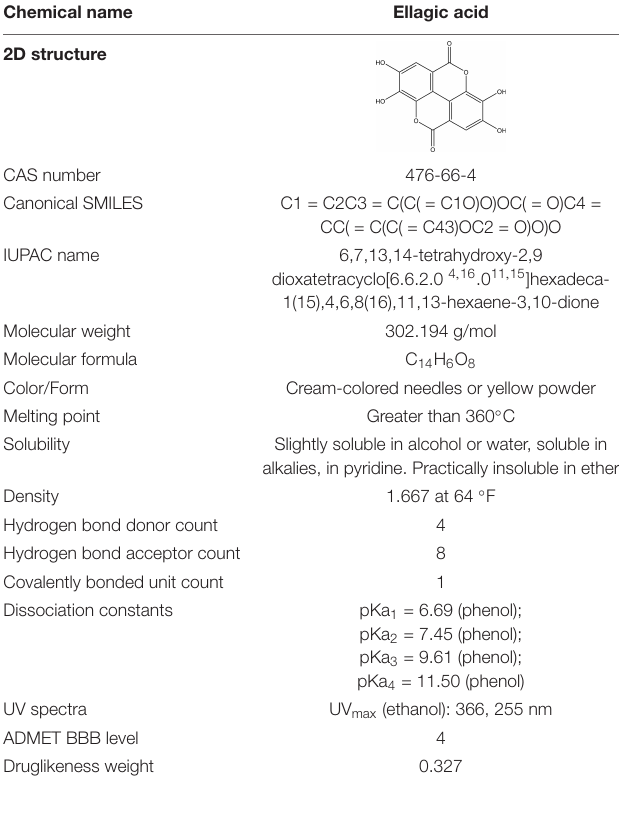
TABLE 1 | Chemical and physical properties of ellagic acid